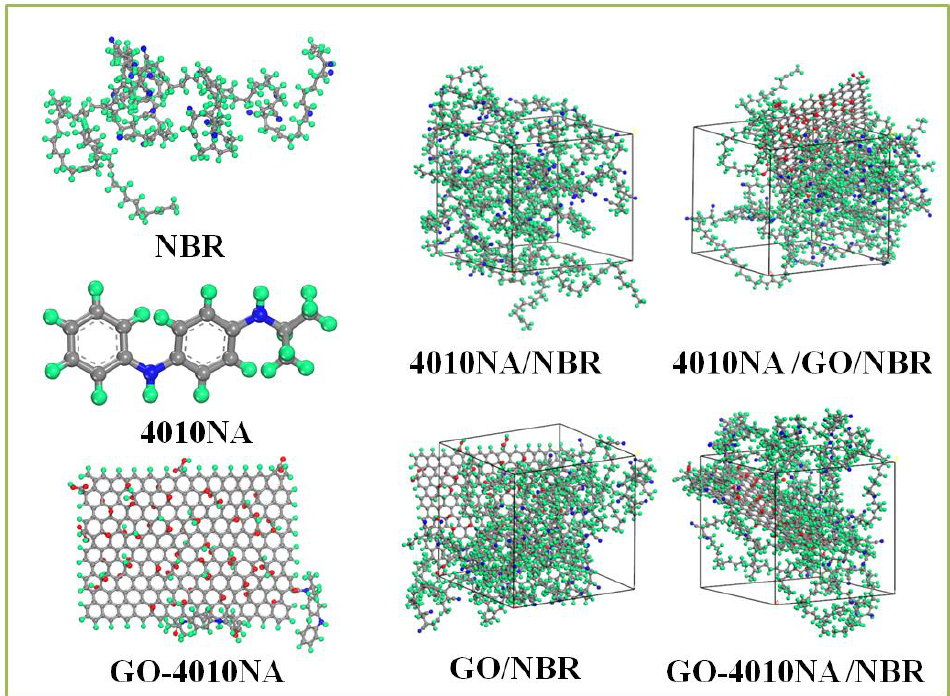
Figure 3. The construction of the 4010NA/NBR, GO/NBR, 4010NA/GO/NBR, and GO-4010NA/NBR composites amorphous cells (The green atom is H, the gray atom is C, the blue atom is N, and the red atom is O).